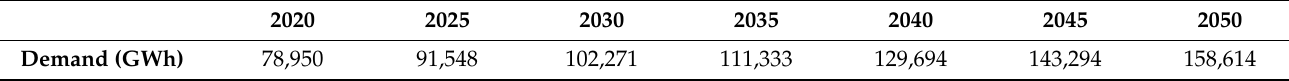
Table 2. Residual capacity and potentials, in GW, for the different generation technologies.